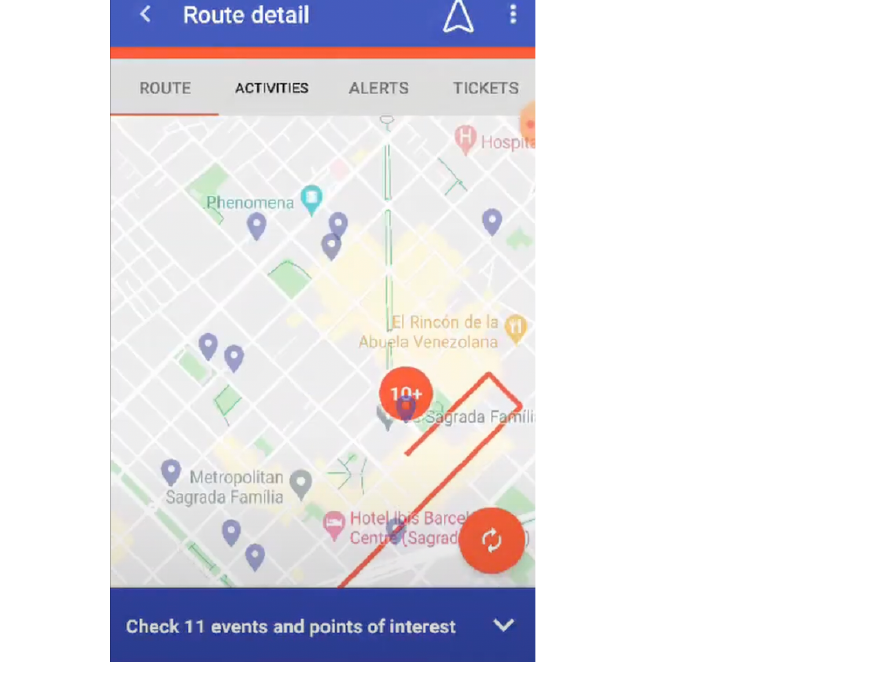
Figure 6. My-Trac recommends activities and point of interest for the user using its Twitter